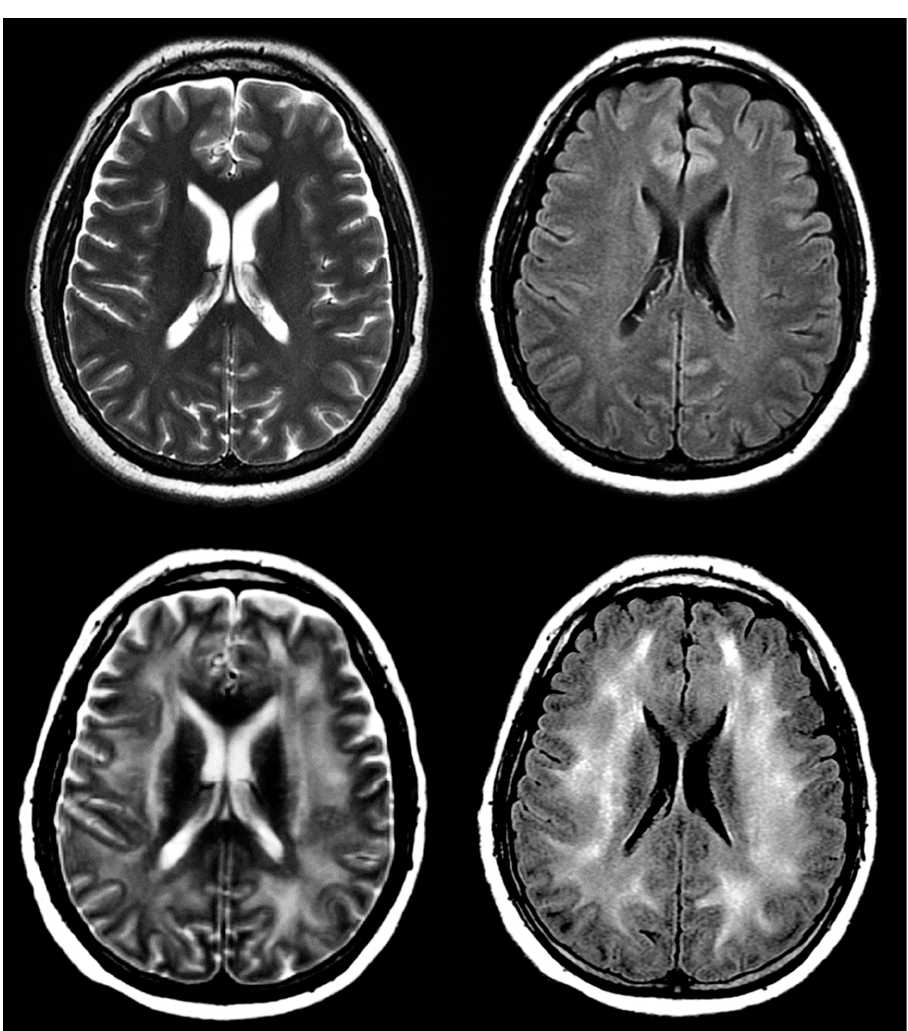
Figure 7. A 43-year-old woman with acute myeloid leukemia and history of confusion and disorientation 7 days post-treatment with CAR T-cells. Select images from axial T2 and FLAIR sequences pre- (above) and post- (below) CAR T-cell therapy demonstrating diffuse hyperintense signal abnormality in subcortical and supratentorial white matter, suspected for ICANS.